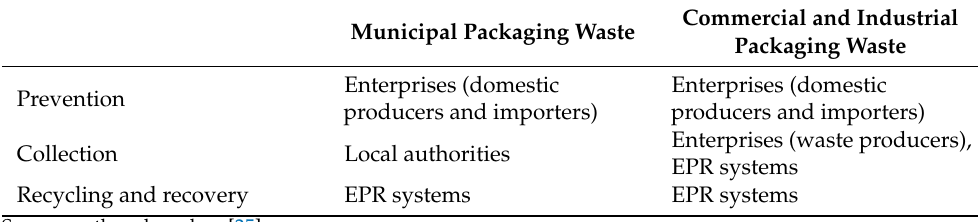
Figure 8. Italian model. Source: own elaboration based on [40]. Table 8. Responsibilities for prevention, collection, recycling, and recovery in